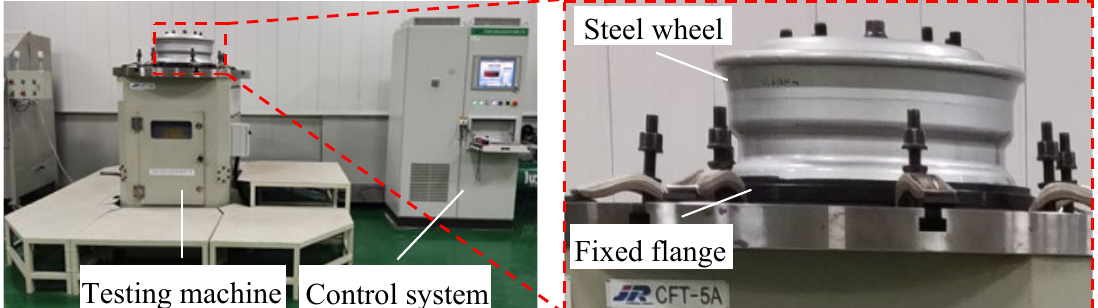
Figure 16. Dynamic bending fatigue test.